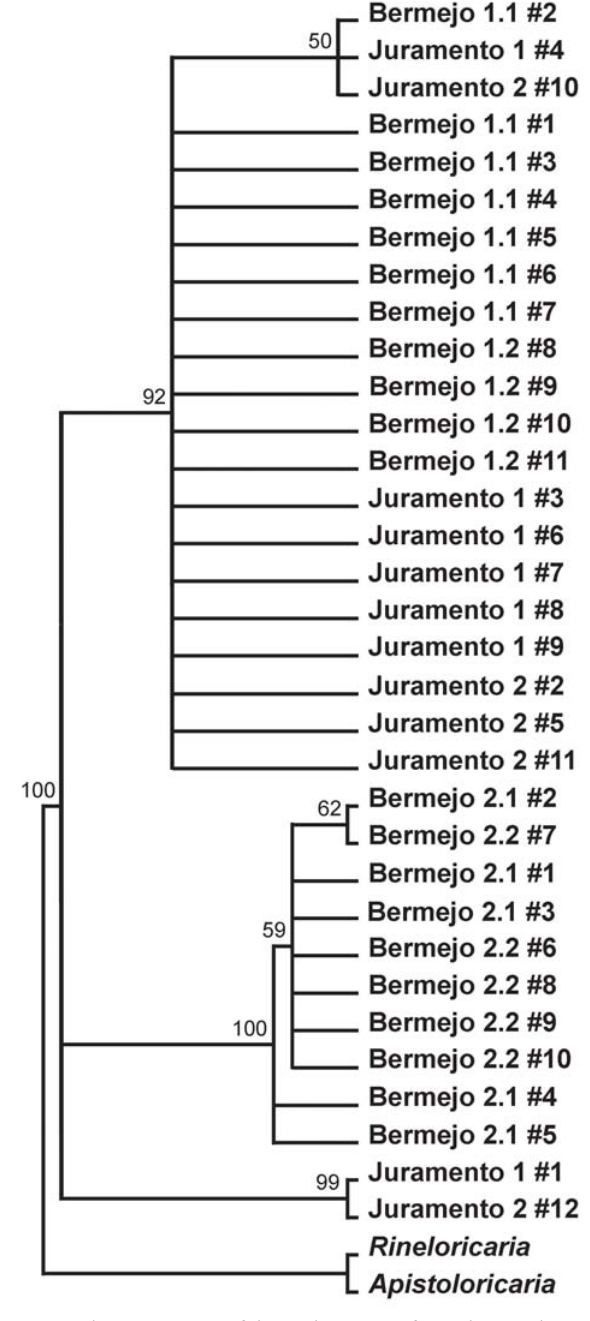
Fig. 2. Strict consensus of the 26 best trees from the maximum parsimony analysis. Tree length: 151. Numbers above branches are values from 1000 bootstrap